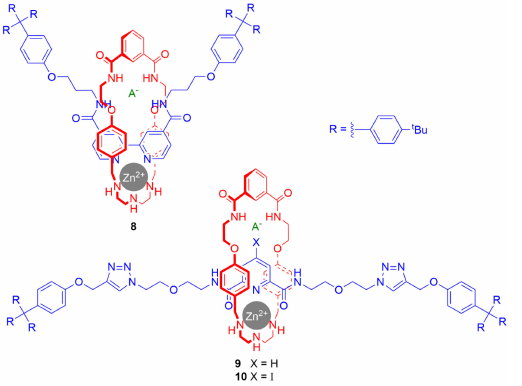
Figure 8. Beer’s tris-amine macrocycle rotaxanes 8 – 10 exhibiting axle separated cooperative ion pair